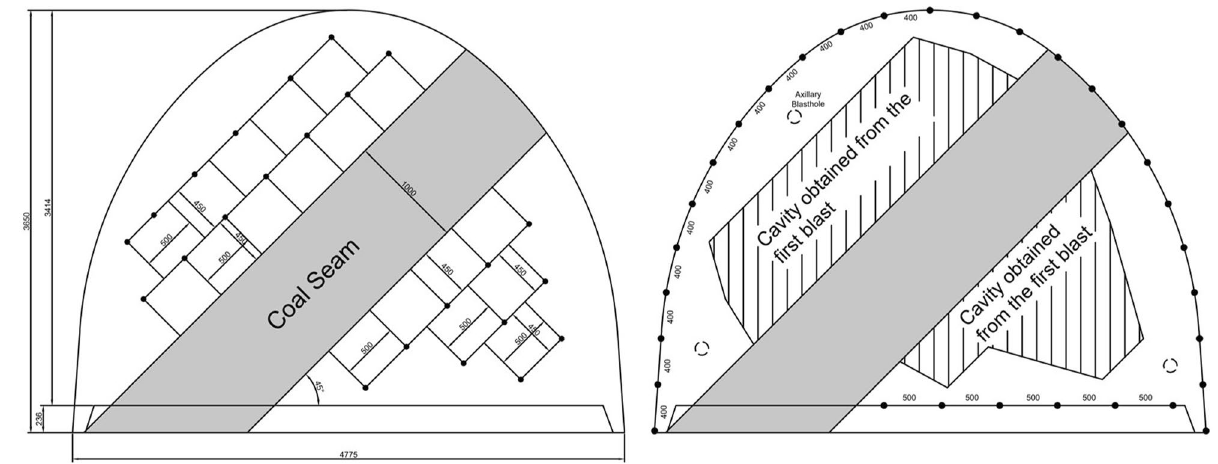
Figure 16. Selected gateroad geometry and placement of the first ( a ) and second ( b ) blast holes.